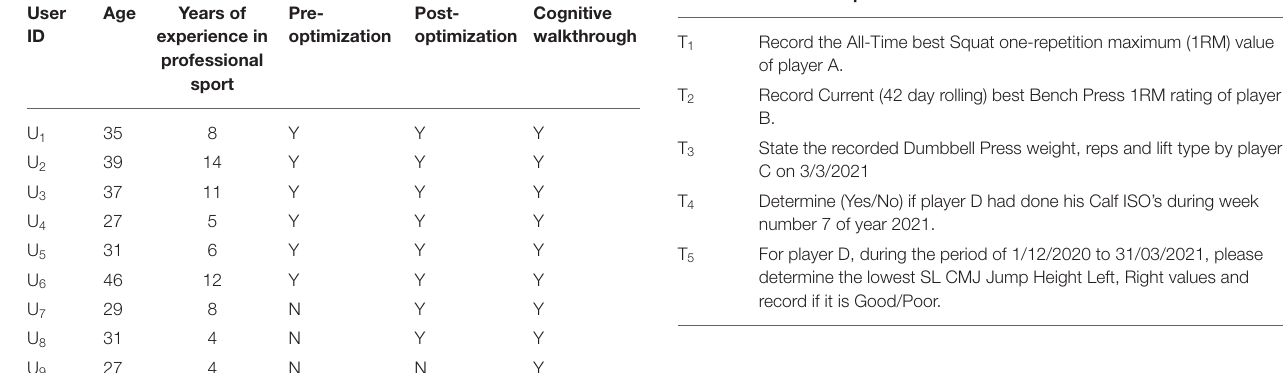
TABLE 2 | Description of tasks designed for the cognitive walkthrough sessions.